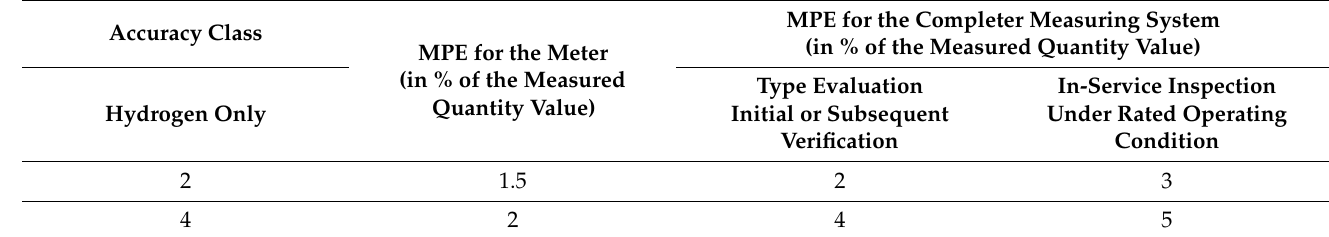
Table 1. MPE value for the hydrogen meter and measuring system in OIML R 139-1 [5].